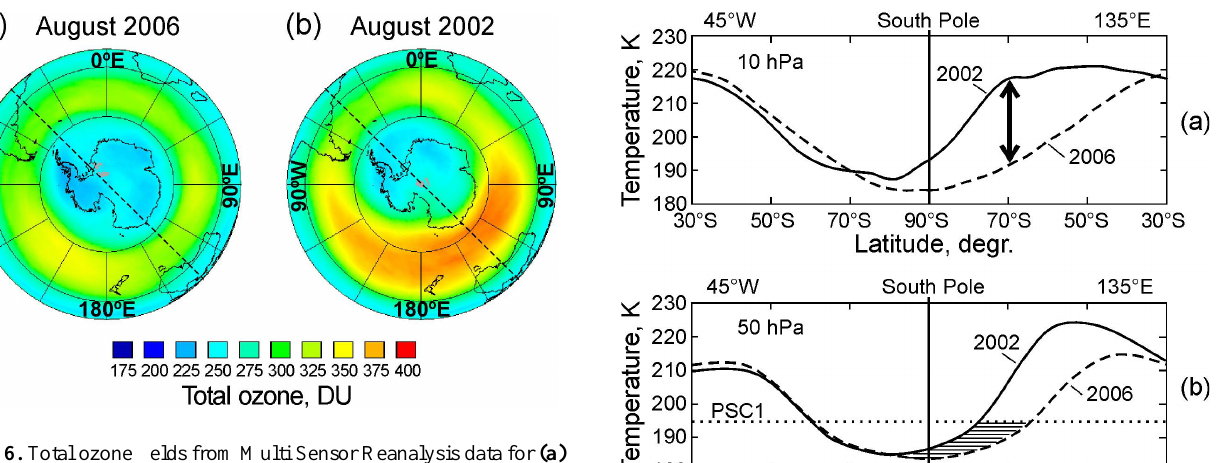
Fig. 6. Total ozone fields from Multi Sensor Reanalysis data for (a) strong and zonally symmetric vortex in August 2006 and (b) weak and zonally asymmetric vortex in August 2002.